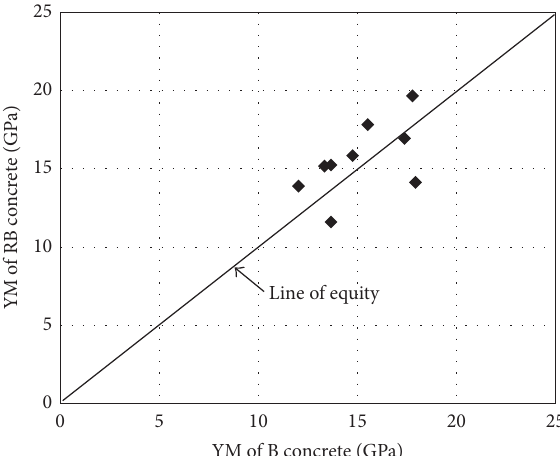
Figure 10: Modulus of elasticity of concrete.